Question: In one sentence, what is this figure communicating?
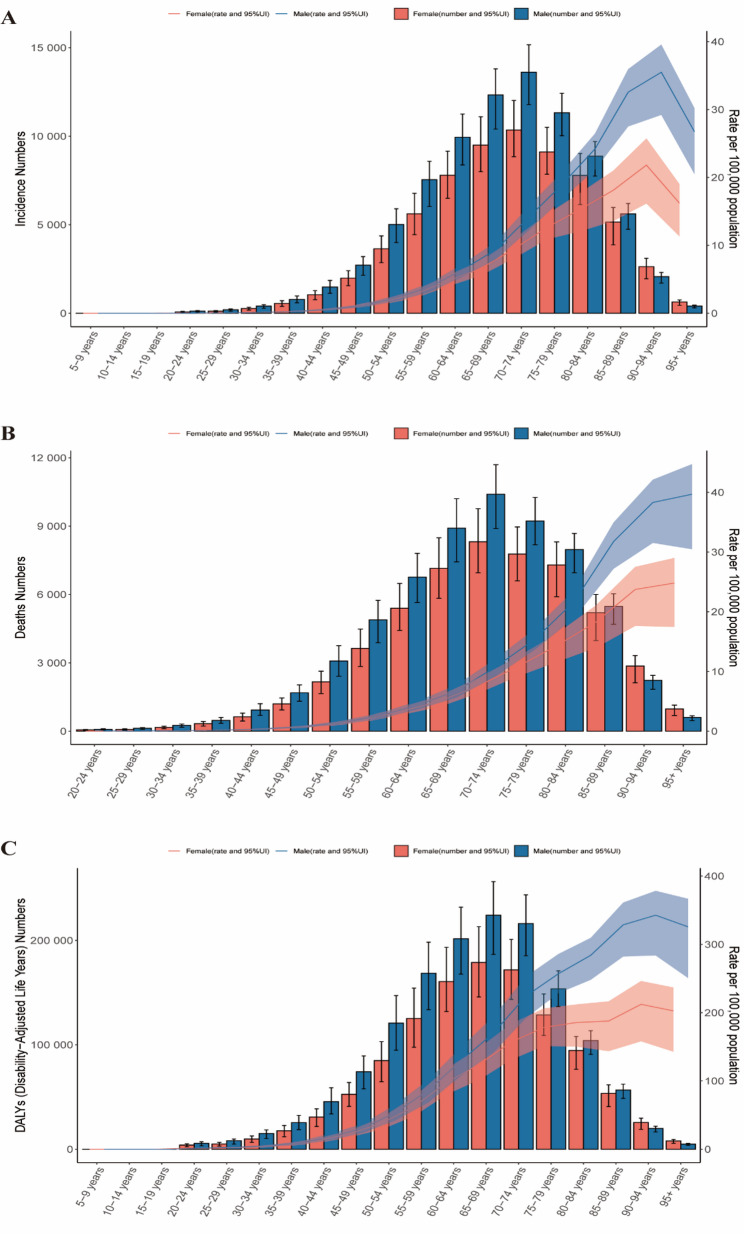
Answer: 2021 multiple myeloma burden distribution across age cohorts. A Incident numbers and age-standardized incidence rate (per 100,000). B Death numbers and age-standardized mortality rate (per 100,000). C DALYs numbers and age-standardized DALYs rate (per 100,000)